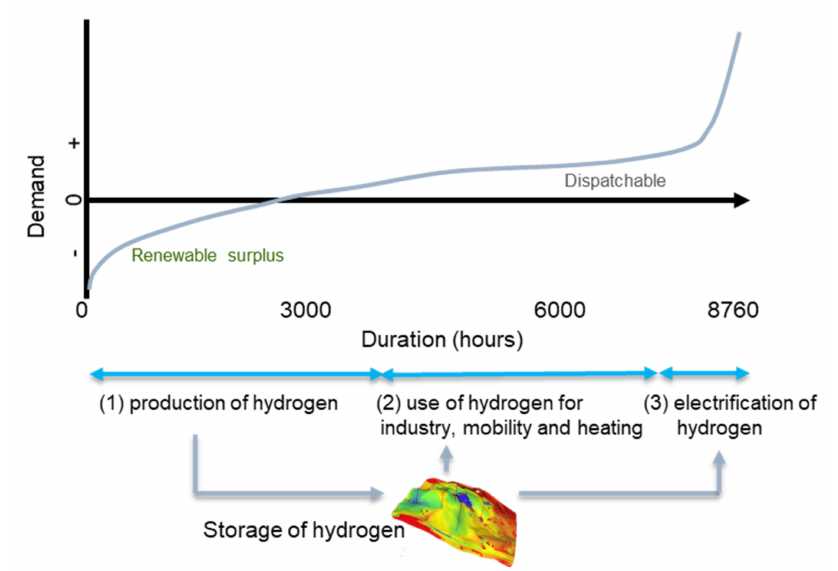
Figure A2. Example renewable energy generation and demand for a high penetration of REN). Three periods can be distinguished [47]: (1) production of hydrogen during REN surplus, (2) use of hydrogen, and (3) electrification of